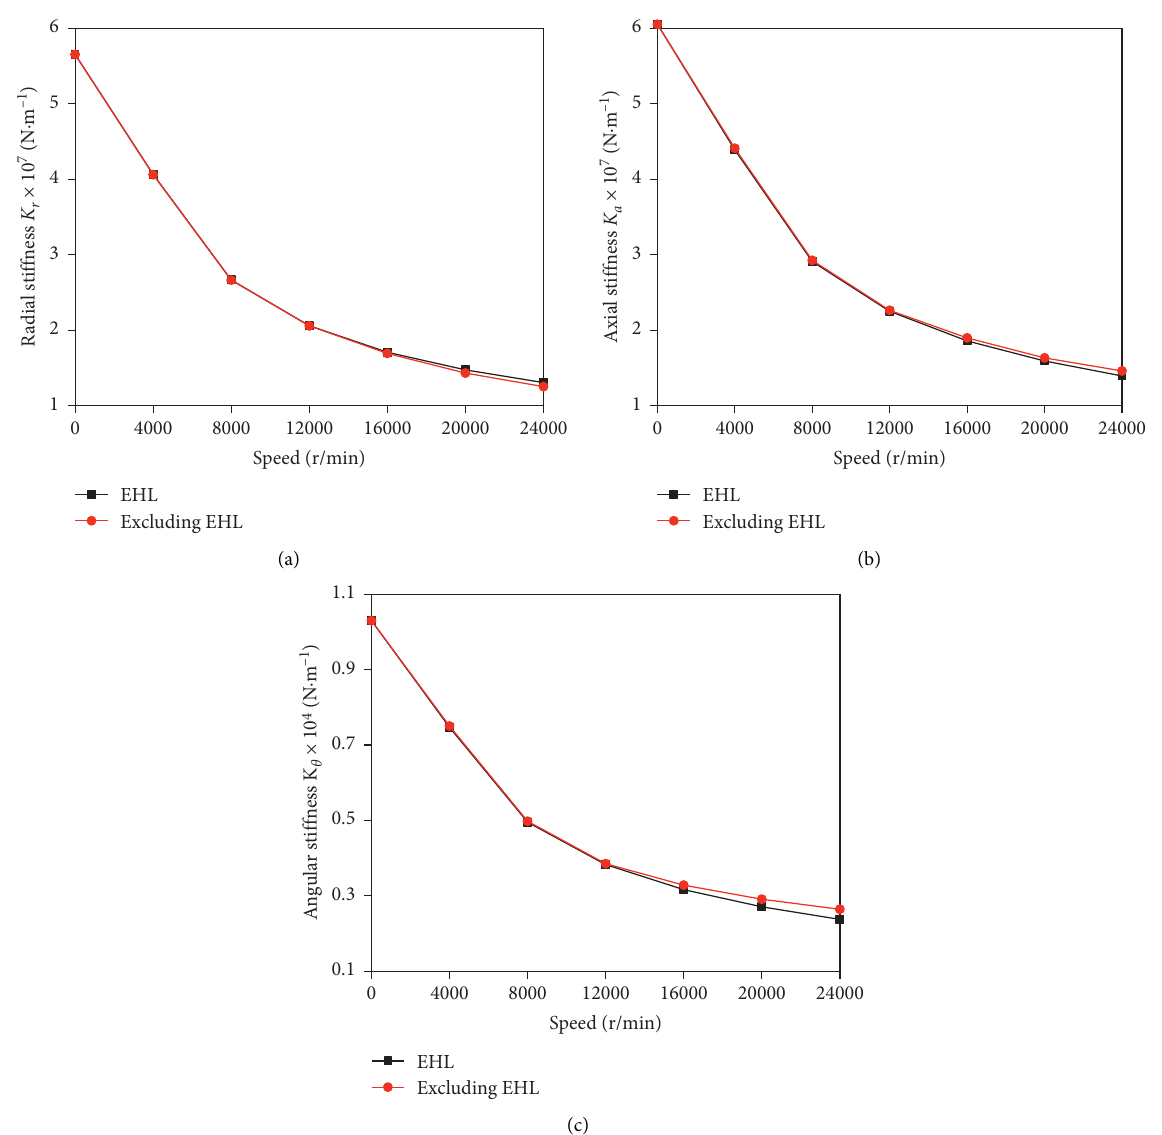
Figure 22: Influences of the speed and EHL on the composite stiffness. (a) Radial stiffness. (b) Axial stiffness. (c) Angular